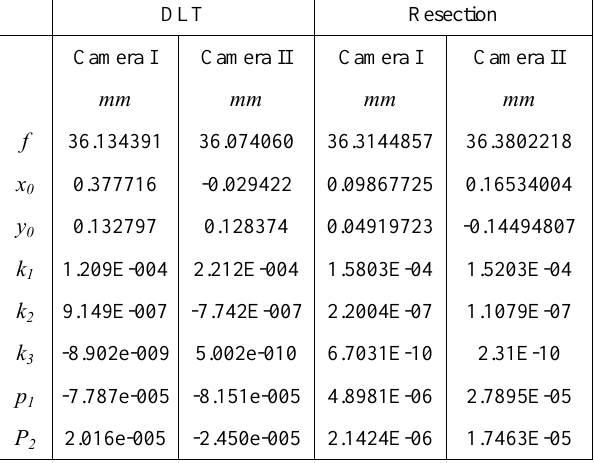
Table 3. The Result of Forward